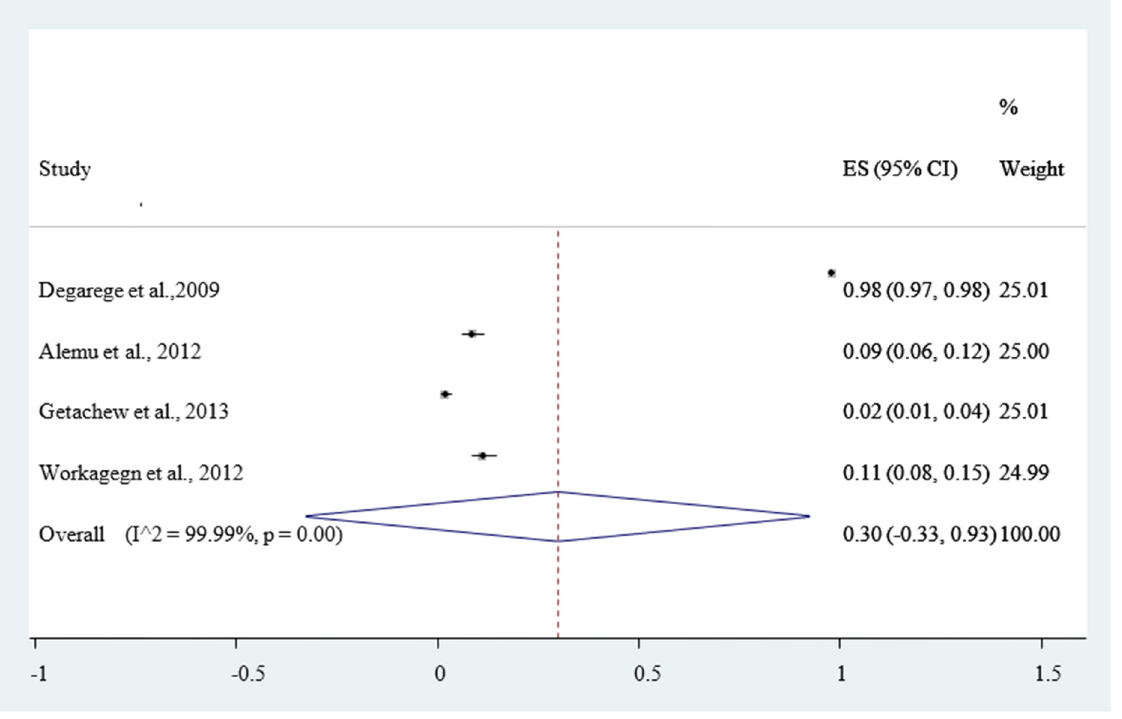
Figure 6. Forest plot of 4 studies on magnitude of Plasmodium falciparum and Plasmodium vivax. mixed infection among outpatients in Ethiopia, 2020.